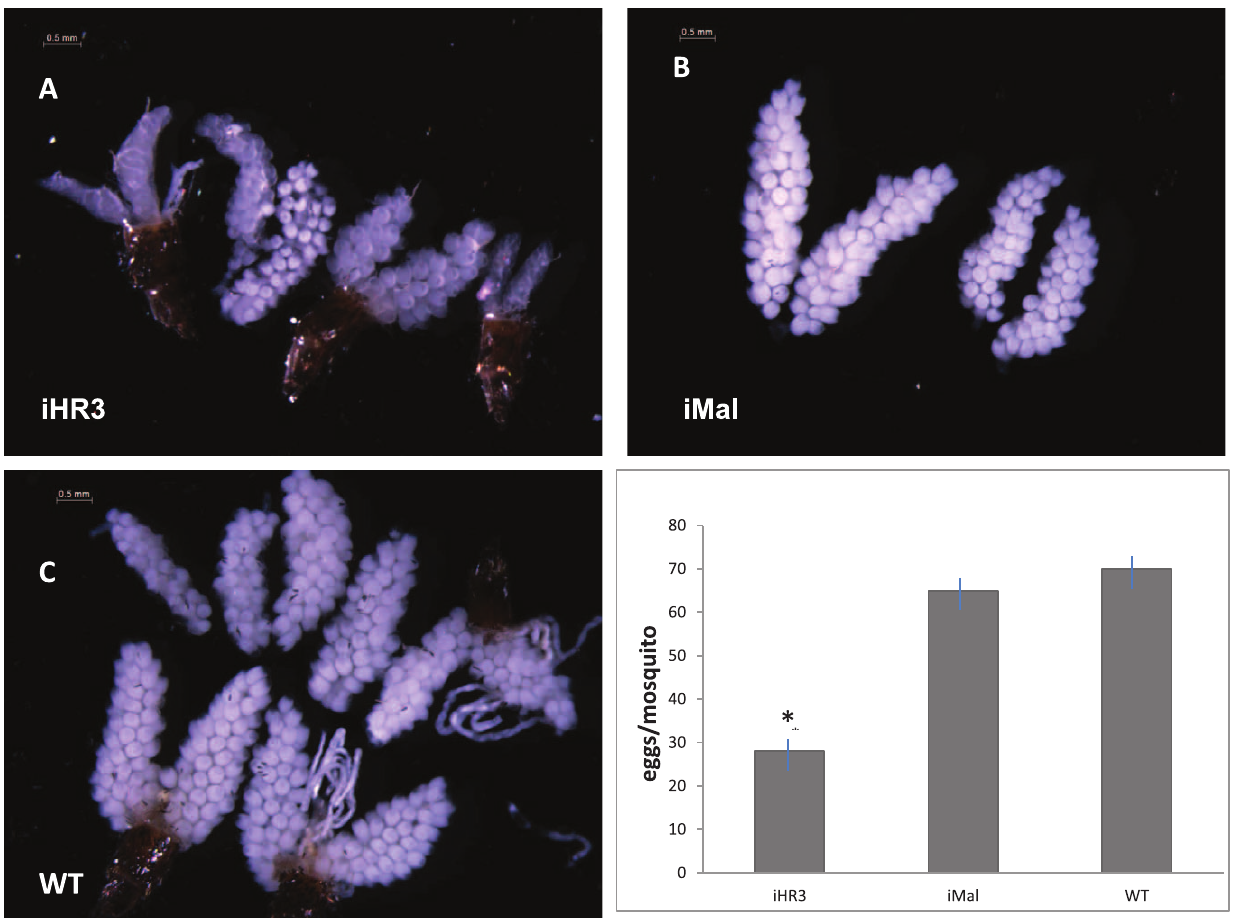
Figure 8. Effect of HR3 RNAi depletion on ovarian development in the second gonadotrophic cycle in Aedes female mosquitoes. A. Representatives of ovaries from iHR3, iMal and untreated wild type female mosquitoes at 24 h PBM. Note that in iHR3 female mosquitoes ovaries are mostly underdeveloped, or lack visible yolk mass (white). Ovaries from iMal mosquitoes were normally developed similar to those of the wild type untreated control mosquitoes. C. Number of eggs per female mosquito in the second gonadotrophic cycle. iMal - HR3 RNA depleted, iMal – dsRNA Mal-treated, and wt - wild type female mosquitoes. The experiment was repeated three times with different cohorts of mosquitoes. *Indicates statistical significance ,